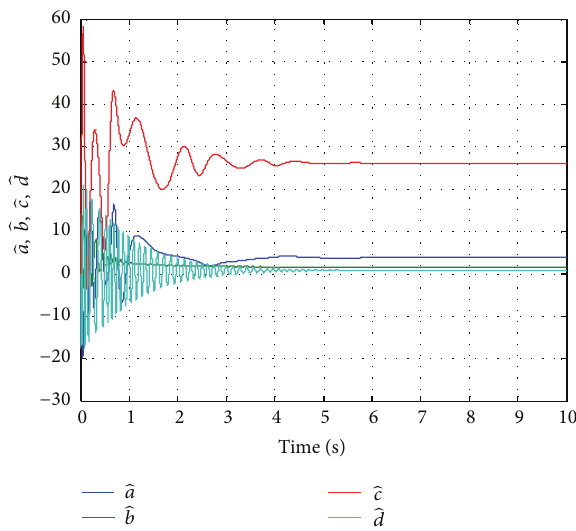
Figure 7: Time histories of estimated parameters for Case